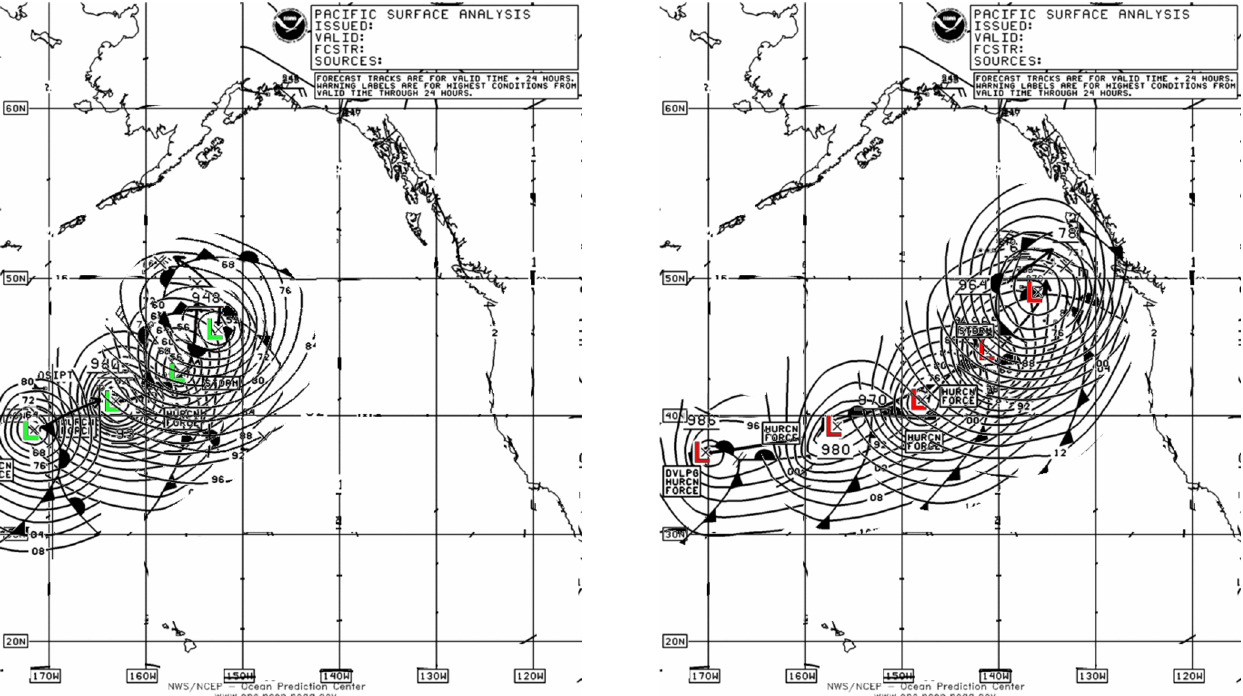
Figure 12. Storm tracks for 16 January 2016 (left) and 18 January 2018 (right). L represents the center of the storm (David B. Elson, personal communication,